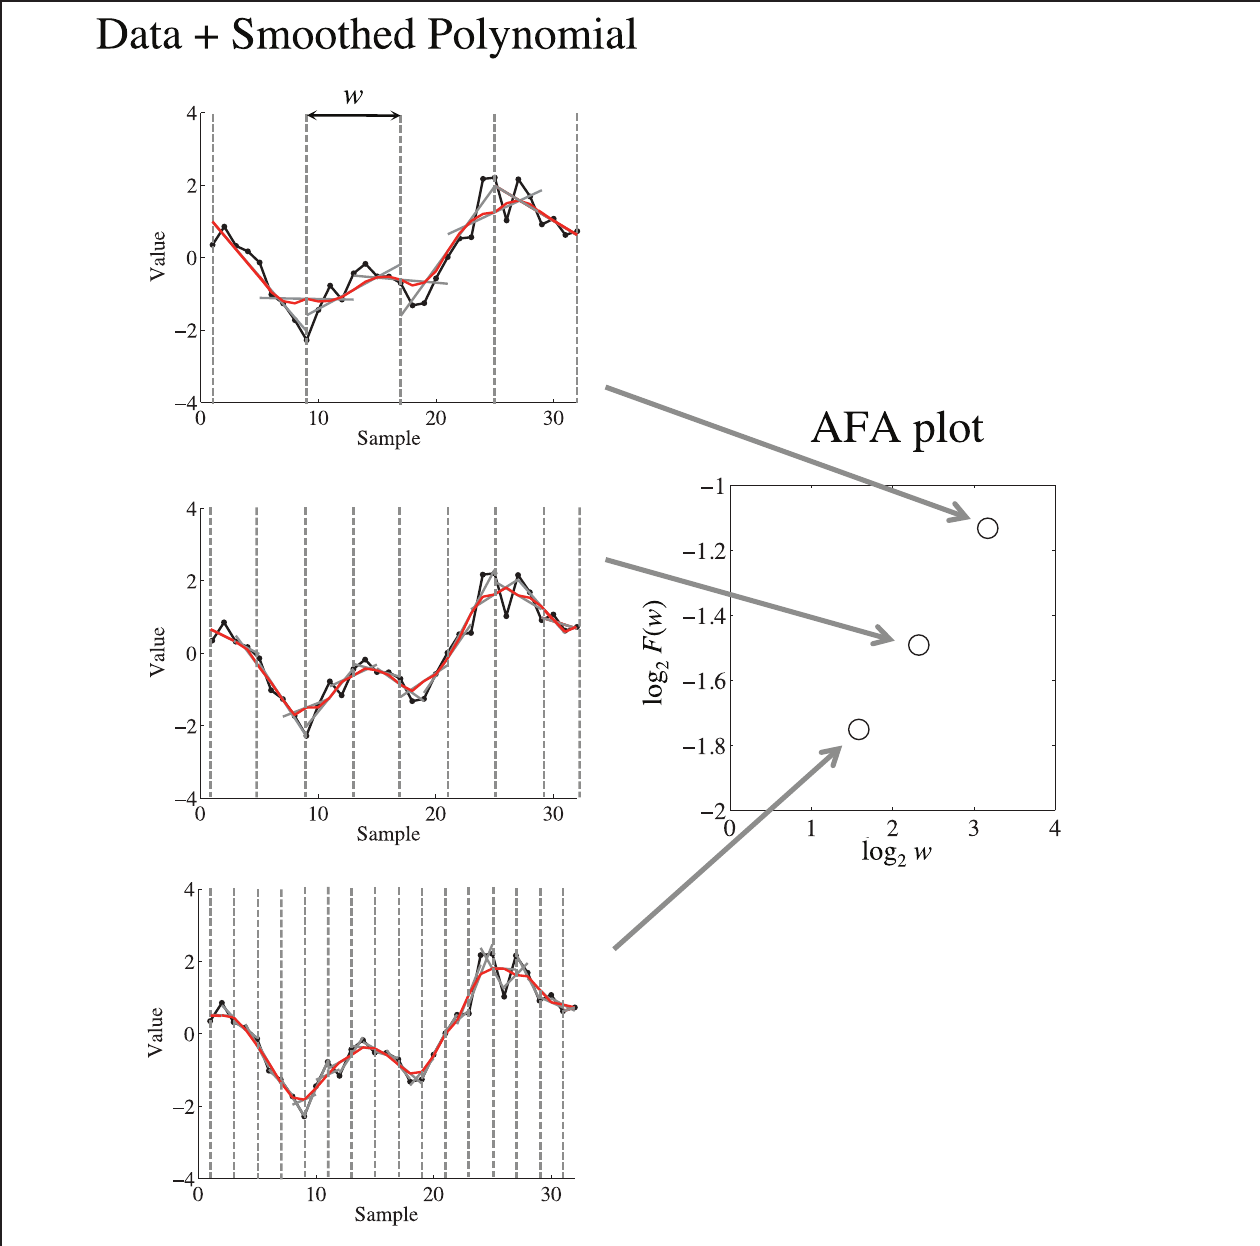
A linear relation in this plot captures fractal scaling, and the slope of the line of best fit provides an estimate of the Hurst exponent H . For visual simplicity we only depicted non-overlapping window edges with the dotted gray line, while the analysis uses overlapping windows.